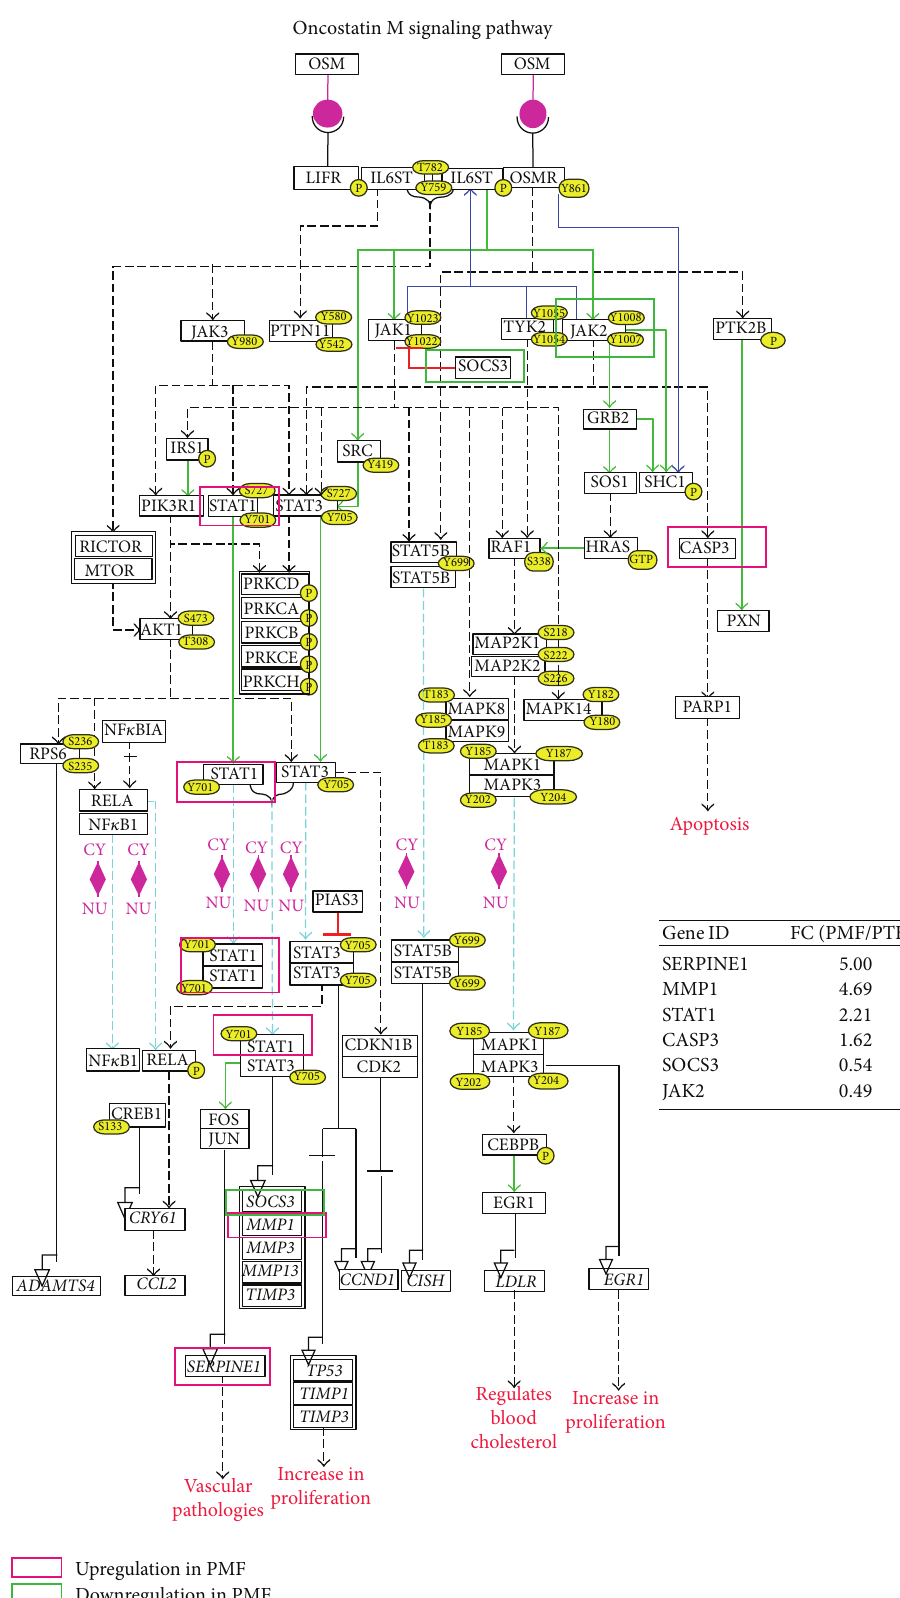
Figure 3: Oncostatin M signalization in mesenchymal stromal cells from PMF patients. WikiPathway diagram of oncostatin M signalization with drawing of genes deregulated in BM-MSCs from PMF patients (transcriptome